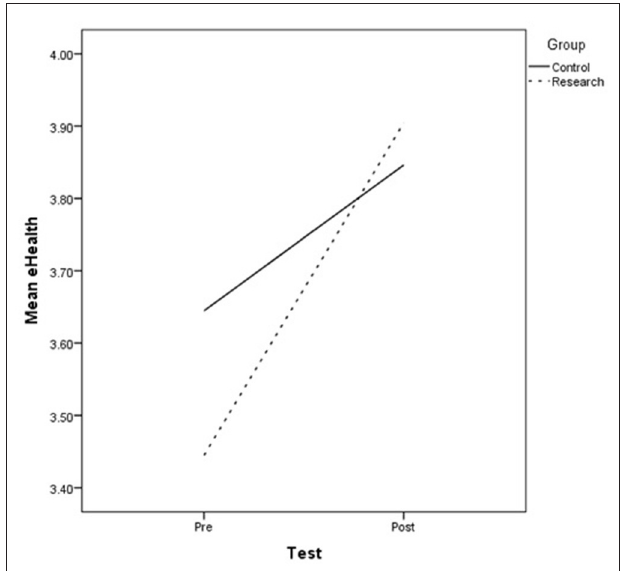
FIGURE 1 | Within-group differences between the